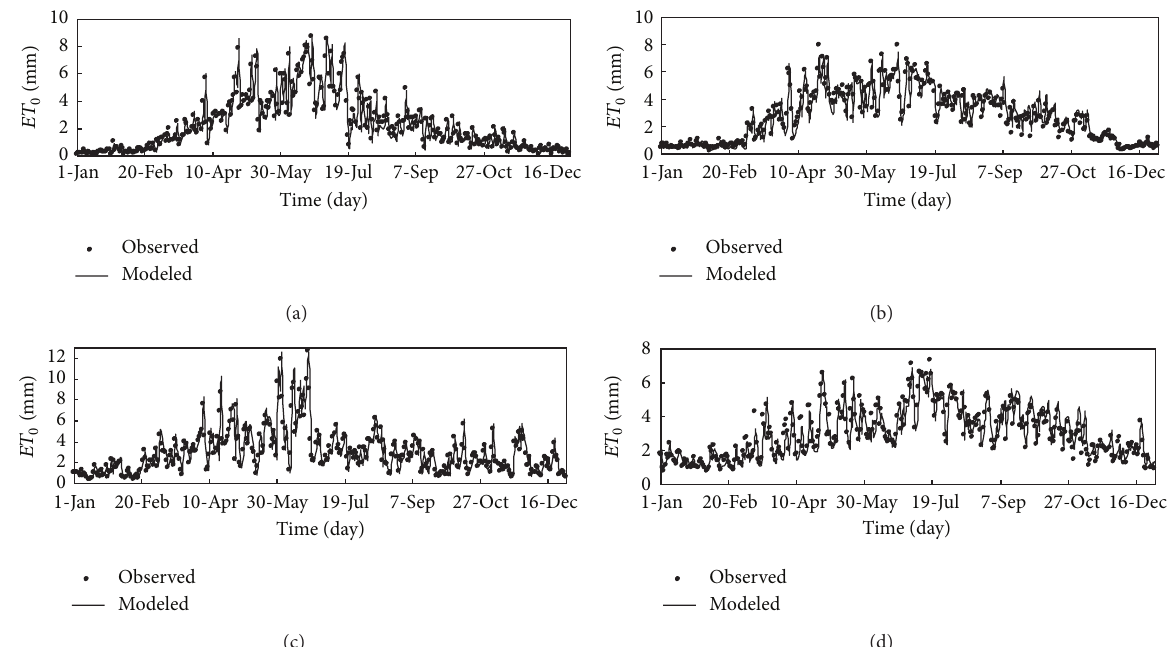
Figure 7: Comparison of observed and predicted daily reference evapotranspiration: (a) Baotou station; (b) Zhangbei station; (c) Kaifeng station; (d) Shaoguan station.